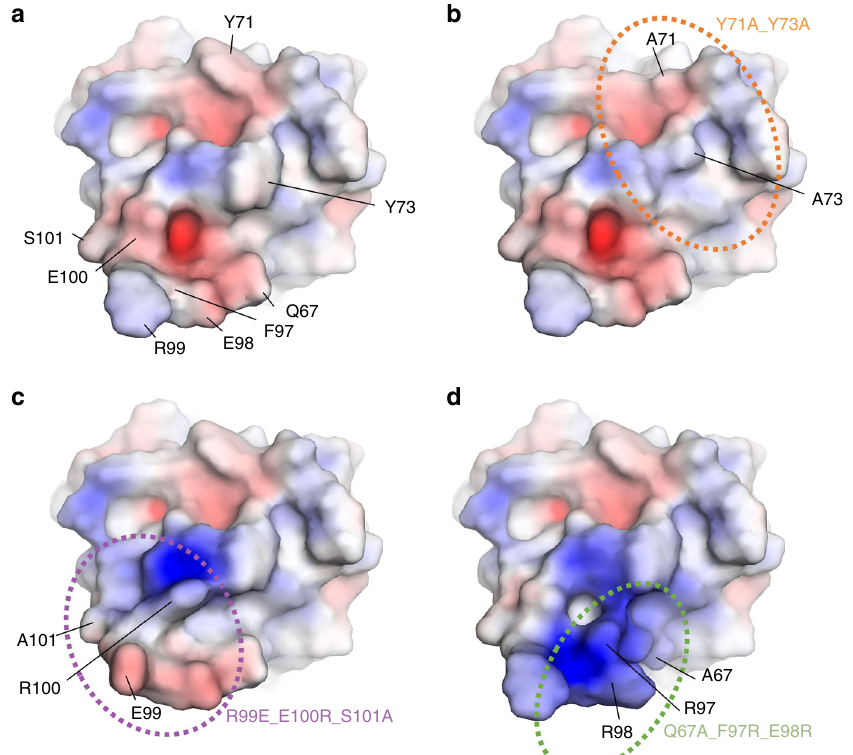
Fig. 4 Visualization of the effect of the MYDGF inactive variants on surface conformation and electrostatics. Electrostatic potential was calculated in PYMOL. The individual panels show the distribution of charges on the surface (negative charges — red; positive charges — blue) of a wild-type MYDGF, b Y71A_Y73 variant, c R99E_E100R_S101A and d